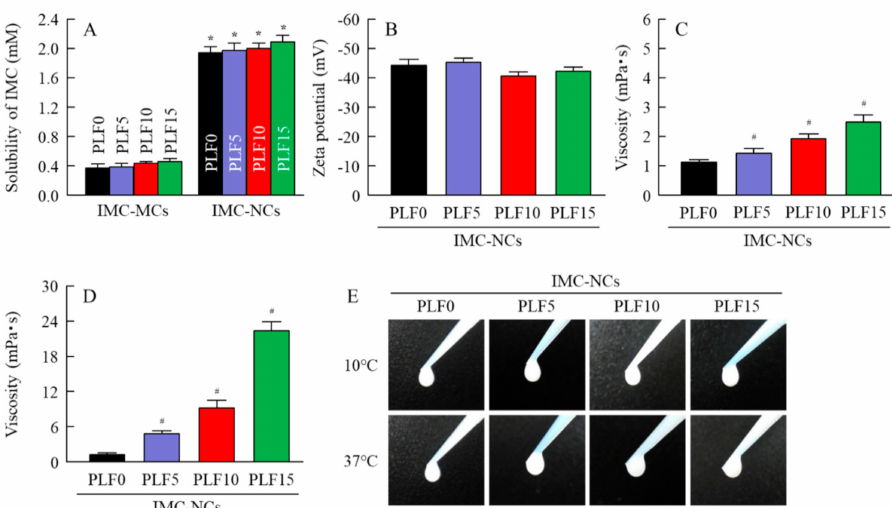
Figure 2. Changes in solubility, zeta potential, and viscosity of each ophthalmic IMC-NC formulation. ( A ) Solubility of IMC in IMC microcrystals (IMC-MCs) and IMC-NCs with Pluronic F-127 (PLF-127). ( B ) Zeta potential of IMC in IMC-NPs, IMC-NC / PLF5, IMC-NC / PLF10, and IMC-NC / PLF15. ( C , D ) Viscosity of IMC-NPs, IMC-NC / PLF5, IMC-NC / PLF10, and IMC-NC / PLF15 at ( C ) 10 ◦ C and ( D ) 37 ◦ C. ( E ) Image of IMC-NPs, IMC-NC / PLF5, IMC-NC / PLF10, and IMC-NC / PLF15 at 10 ◦ C and 37 ◦ C. Compositions of each ophthalmic IMC-NC formulation shown in Table 1; n = 7–8; * p < 0.05 vs. IMC-MC for each category, # p < 0.05 vs. PLF0 (IMC-NPs). The addition of PLF-127 did not a ff ect IMC solubility and zeta potential in IMC-NC-incorporating ISG. The viscosity of ophthalmic PLF-127-based IMC-NC-incorporating ISG was higher at 37 ◦ C than at 10 ◦ C. In particular, the gelation of IMC-NC / PLF10 and IMC-NC / PLF15 was promoted at 37 ◦ C, with viscosity of approximately 9.2 and 22.3 mPa · s, respectively.